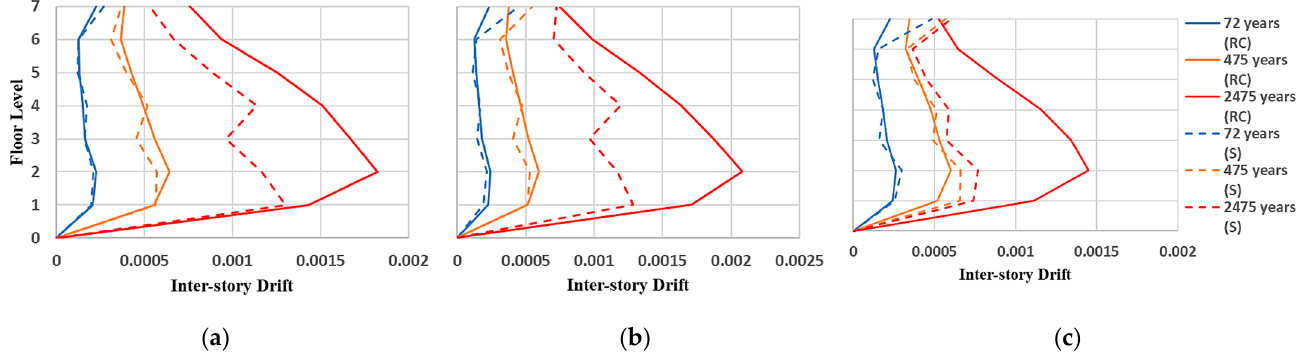
Figure 8. ( a ) Ciudad Victoria, Tamaulipas, ( b ) Ciudad Victoria, Tamaulipas, ( c ) Ciudad Victoria, Tamaulipas. Mean of the maximum inter-story drift response for each level of the steel and reinforced concrete structural model for seismic zone A.